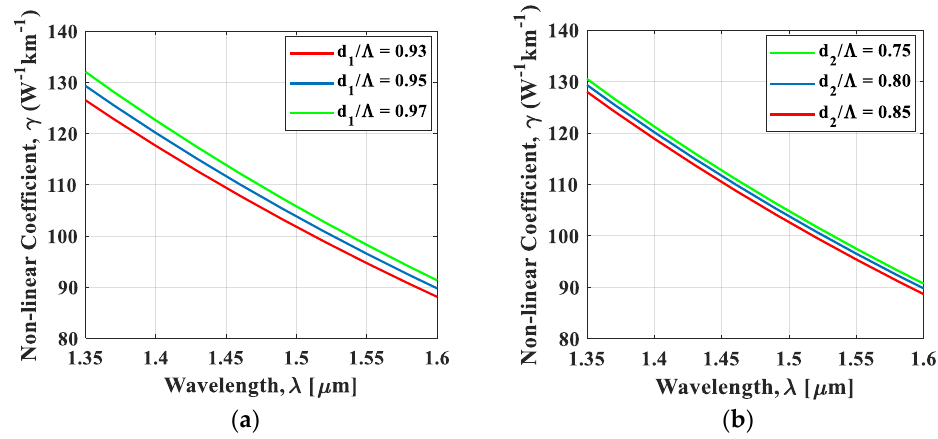
Figure 7. Effect of changing ( a ) d 1 /Λ on nonlinearity, when the remaining parameters ( Λ = 0.76 and d 2 /Λ = 0.80 ) were kept constant; and ( b ) d 2 /Λ on nonlinearity, when the remaining parameters ( Λ = 0.76 and d 1 /Λ = 0.95 ) were kept constant.